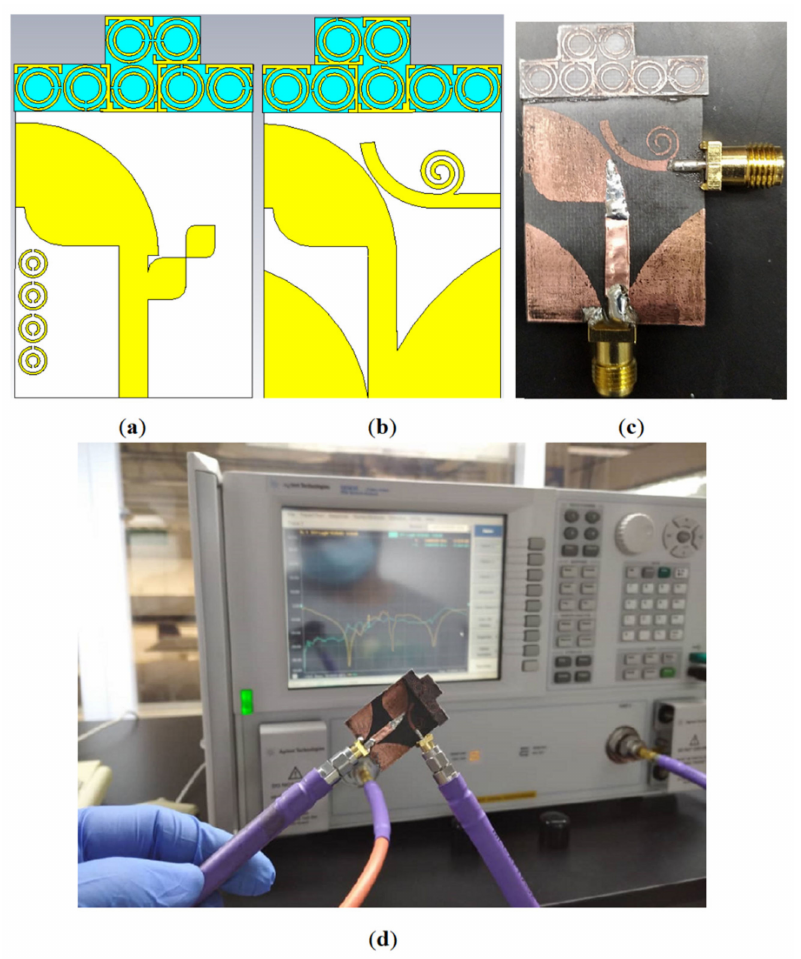
Figure 12. The AVA antenna integrated with the MTM elements: ( a , b ) the simulated structure, ( c ) the measured prototype, and ( d ) the measurement setup.